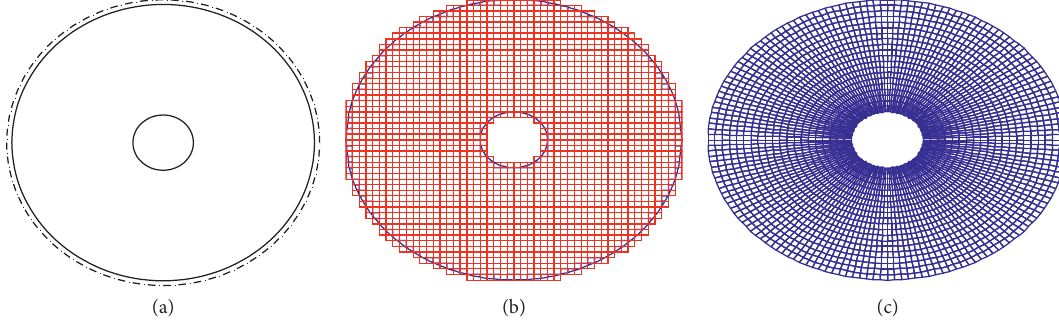
Figure 13: An annular plate with its outer edge being simply supported and its inner edge being free (a); 0.2 × 0.2 mesh of the plate divided for the proposed NMM and the traditional NMM (b); the mesh with 3200 elements of the plate divided for the FEM (c).